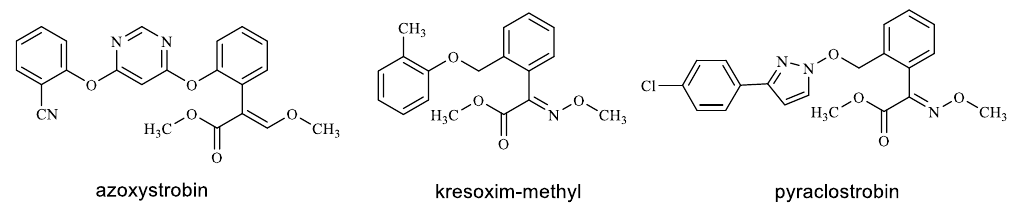
Figure 1. The chemical structures of strobilurin fungicides.